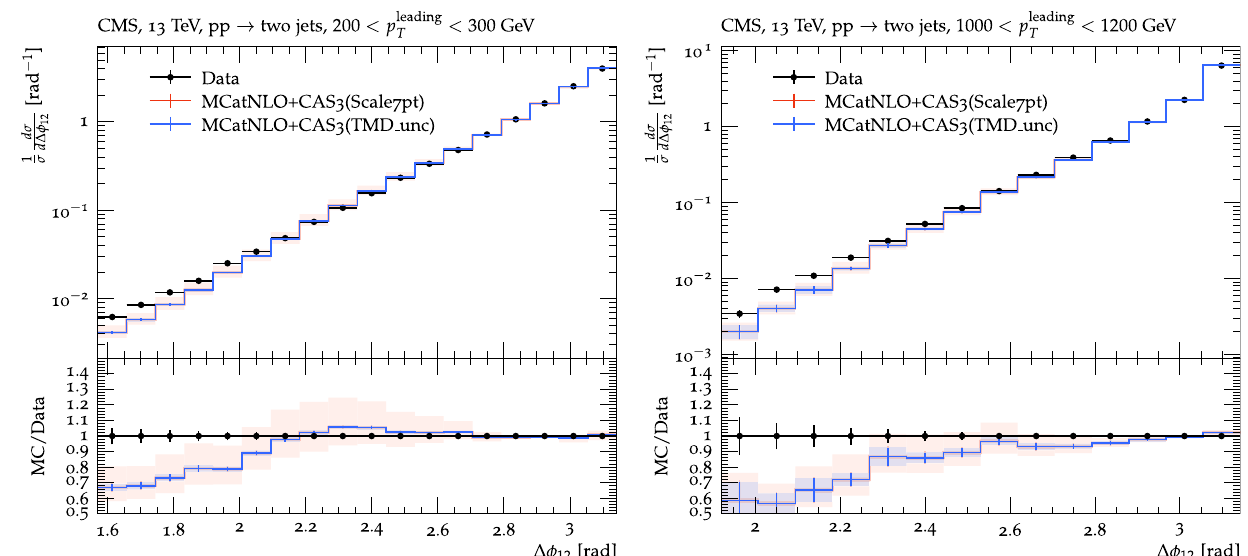
> 200 GeV (left) and p leading > 1000 GeV (right) as measured by CMS [26] compared with Fig. 4 Azimuthal correlation (cid:2)φ 12 for p leading T T predictions from MCatNLO+CAS3. Shown are theuncertaintiescoming from the scalevariation (as describedinthe text)aswell as theuncertainties coming from the TMD